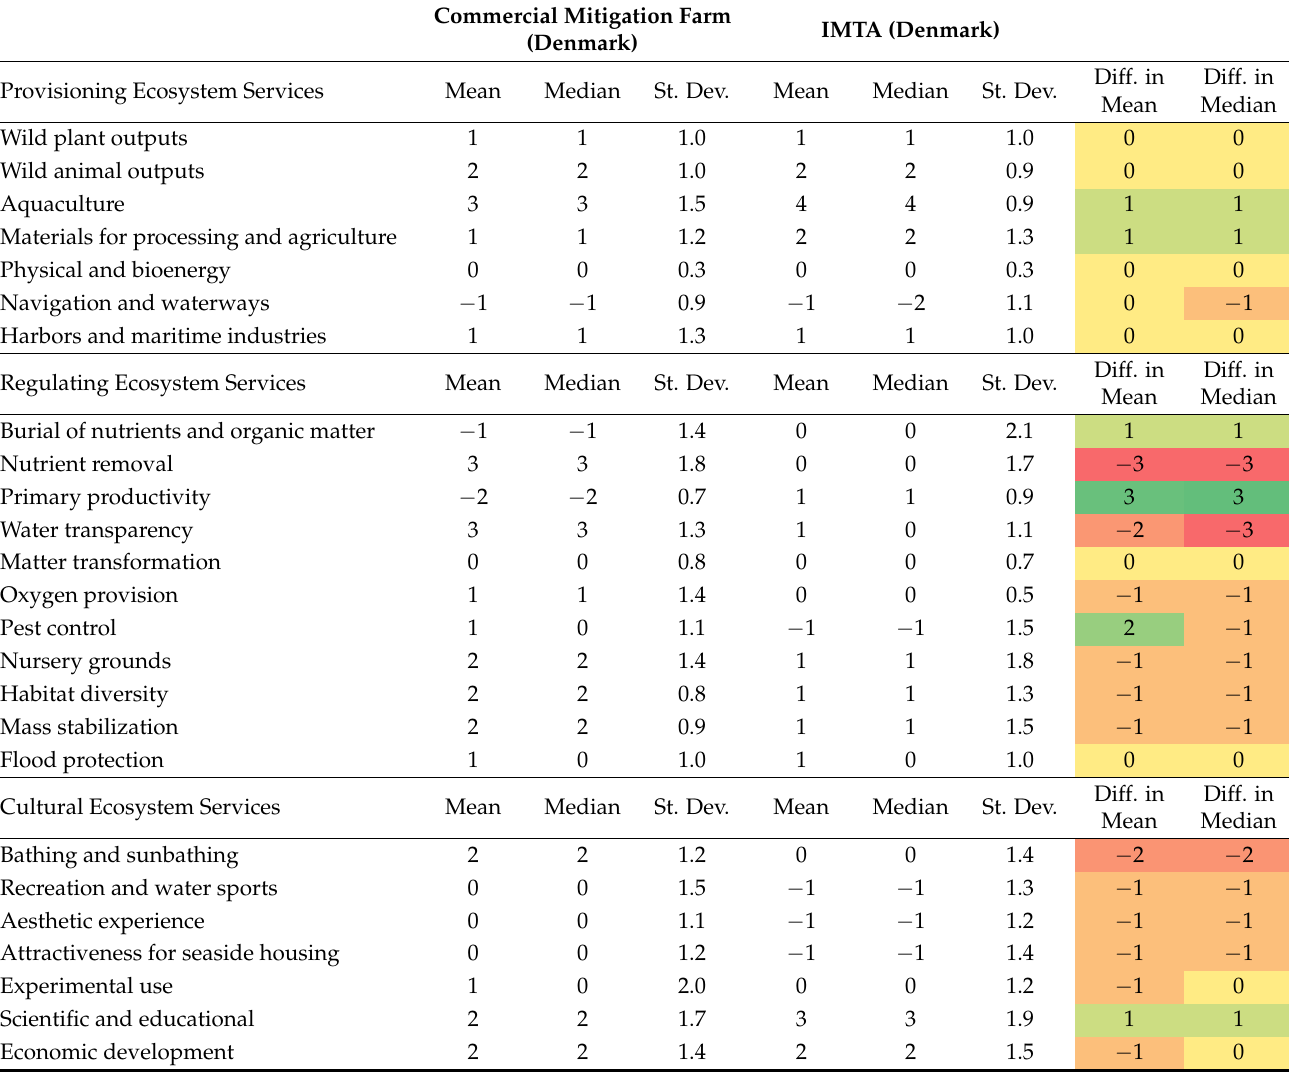
Table 6. Comparison of two mussel farm applications assessing the effects (changes) on ecosystem services. The mussel farm applications included an IMTA approach (Horsens Fjord) and a large- scale commercial mitigation mussel farm (Skive Fjord), both located in Danish coastal waters. The assessment was conducted by experts with mussel cultivation backgrounds. The mean and median values were calculated based on the aggregated number of